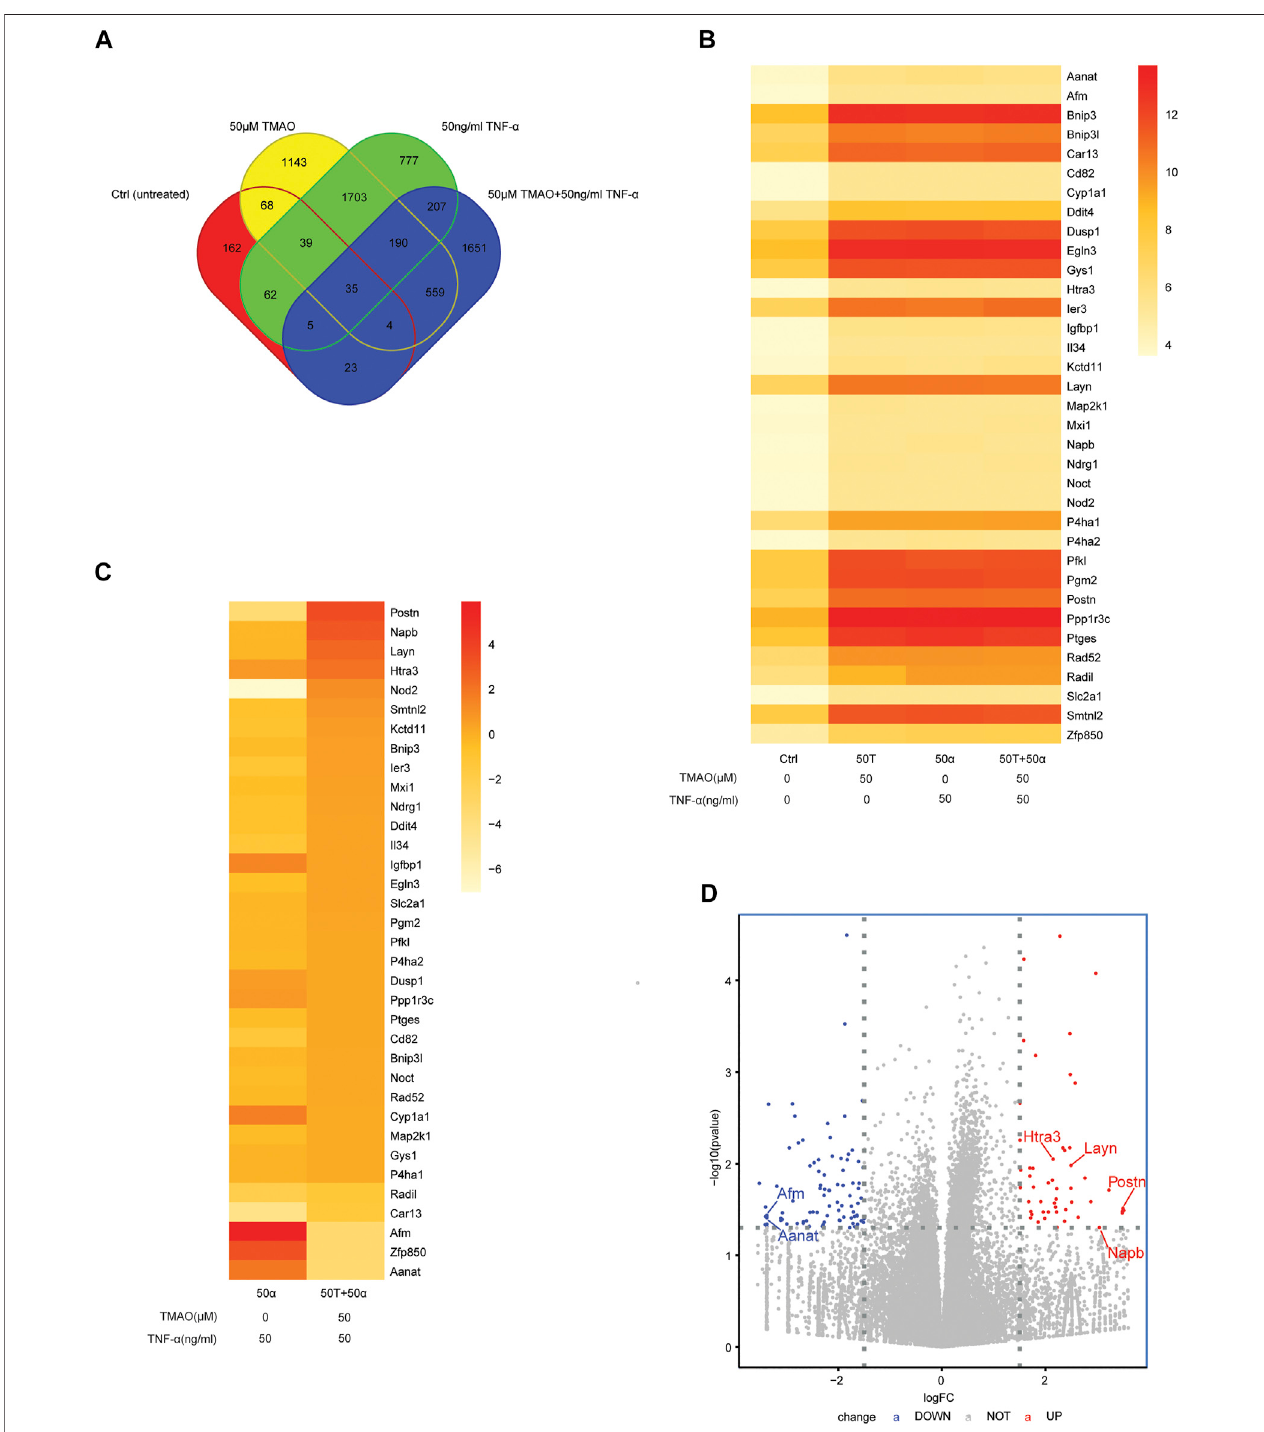
FIGURE 2 | Transcriptomic alterations in TMAO-induced primary liver cancer cells. (A) Venn diagrams showing the crossover between the differentially expressed genes (DEGs) in untreated Hepa1-6 cells (Group Ctrl), and Hepa1-6 cells treated with 50 μ M TMAO alone (Group 50T), 50 ng/ml TNF- α alone (Group 50 α ) or 50 ng/ml TNF- α and 50 μ M TMAO in combination (Group 50T + 50 α ). (B) Heatmap showing the DEGs common to the four treatment groups; FC > 2 and p < 0.05. (C) Heatmap showing the DEGs common to Group 50 α and Group 50T + 50 α ; FC > 2 and p < 0.05. (D) Volcano map showing the signi fi cant differentially expressed genes between Group 50 α and Group 50T + 50 α ; FC > 2 and p < 0.05 ; FC: Fold change.